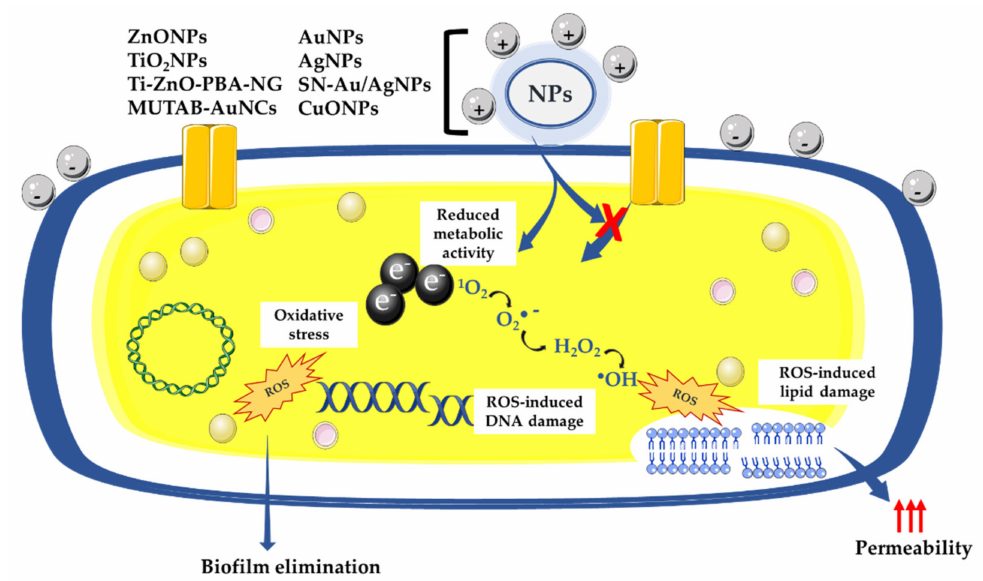
Figure 1. Antibacterial effect of oxidative stress mediated by metal-based NPs: NPs, nanoparticles; AuNPs, gold nanoparticles; AgNPs, silver nanoparticles; SN-Au/AgNPs, silicon nanowire arrays modified with Au/Ag alloy NPs; CuNPs, copper nanoparticles; ZnONPs, zinc oxide nanoparticles; TiO 2 NPs, titanium dioxide nanoparticles; Ti-ZnO-PBA-NG, zinc oxide-3-carboxyphenylboronic acid- naringin; MUTAB-AuNCs, N , N , N -trimethylammonium bromide-gold nanoclusters; ROS, reactive oxygen species; 1 O 2 , singlet